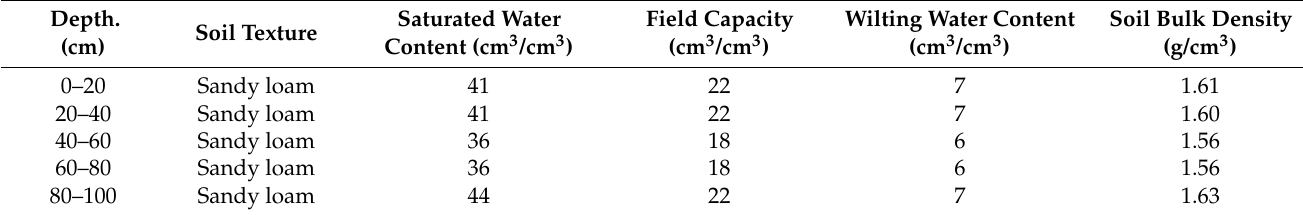
Table 1. Soil physical properties at the experimental site.